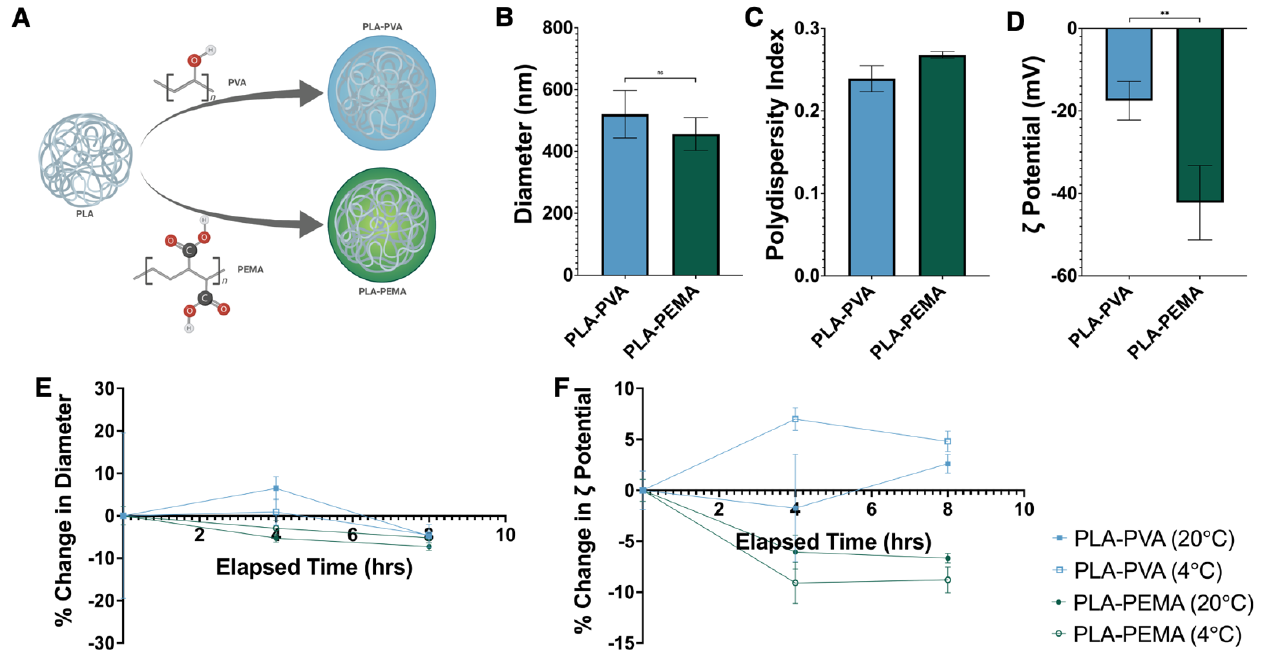
Figure 1. Physicochemical characterization of the synthesized iNPs. ( A ) Schema of the particle formulations utilized for this study. ( B ) Particle diameters were optimized to be in the range of 400-600 nm with ( C ) polydispersity indices in the range of 0.150-0.250. ( D ) Particles were also standardized across surface charge as represented by ζ potential. Additionally, particle stability following reconstitution in distilled water was determined at room temperature (20 °C) and refrigeration (4 °C) over a course of 8 h to confirm stability of particle size ( E ) and zeta potential ( F ). Schematic in ( A ) created with BioRender. Statistical differences between groups were determined by performing Student’s t -test. Error bars represent SD. ** for p ≤ 0.01 and ns = not significantly different ( p >